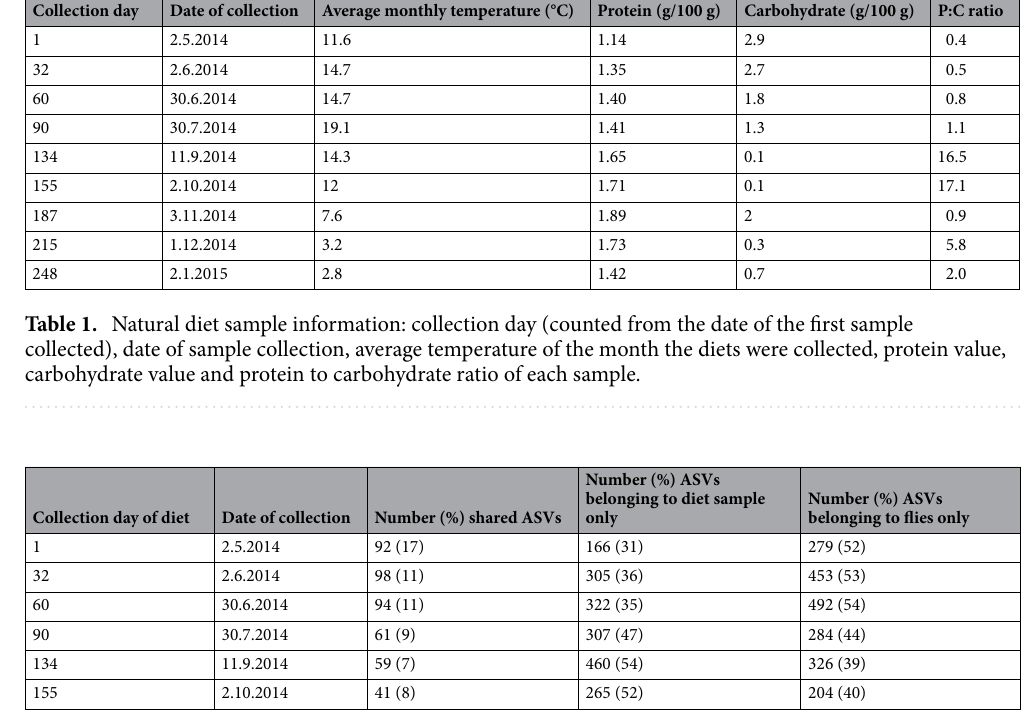
Table 2. The distribution of ASVs when the fly samples are grouped with their respective diet. The percentage of the total ASV counts is shown in brackets.